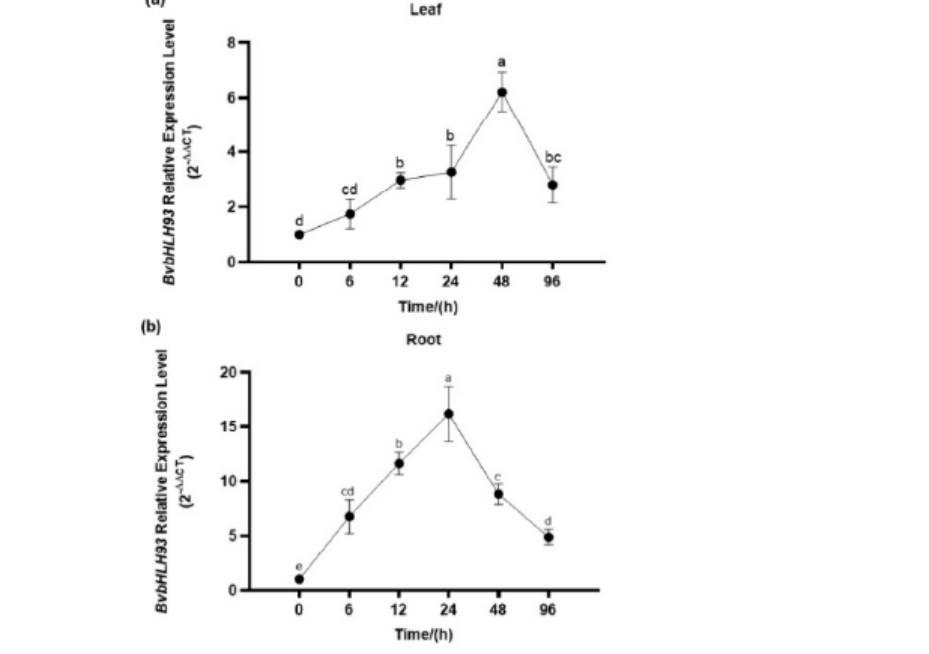
Figure 3. BvbHLH93 expression patterns in response to salt stress treatments. ( a ) Leaves and ( b ) roots of the sugar beet plants treated with 200 mM NaCl for different time periods. Data are the means of three biological replicates with standard deviation (SD) bars. Different letters indicate significant difference at p < 0.05.